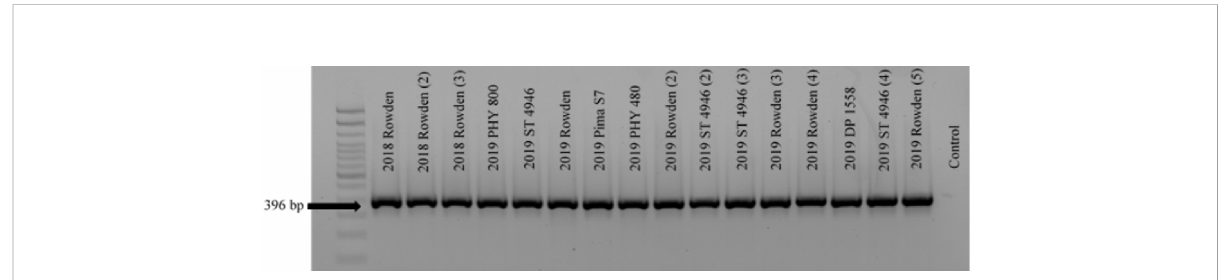
FIGURE 4 Gel electrophoresis image of a PCR analysis for the detection of T ƒ o1, MITE/T ƒ o1, MULE/T ƒ o1 insertions into the PHO gene of FOV isolates which are commonly found in FOV race 4 isolates in the United States. Bands appear at 396 bp when no insertion is present, 583 bp when the T ƒ o1 insertion is present, 426 bp when the MULE/T ƒ o1 insertion is present, and 663 bp when the MITE/T ƒ o insertion is present. Isolates shown are lane 1, 100 bp DNA ladder; lane 2-17, MDS-12 isolates of FOV; lane 18 water control. All isolates produced a band at 396 bp showing the lack of a T ƒ o insertion into the PHO gene.